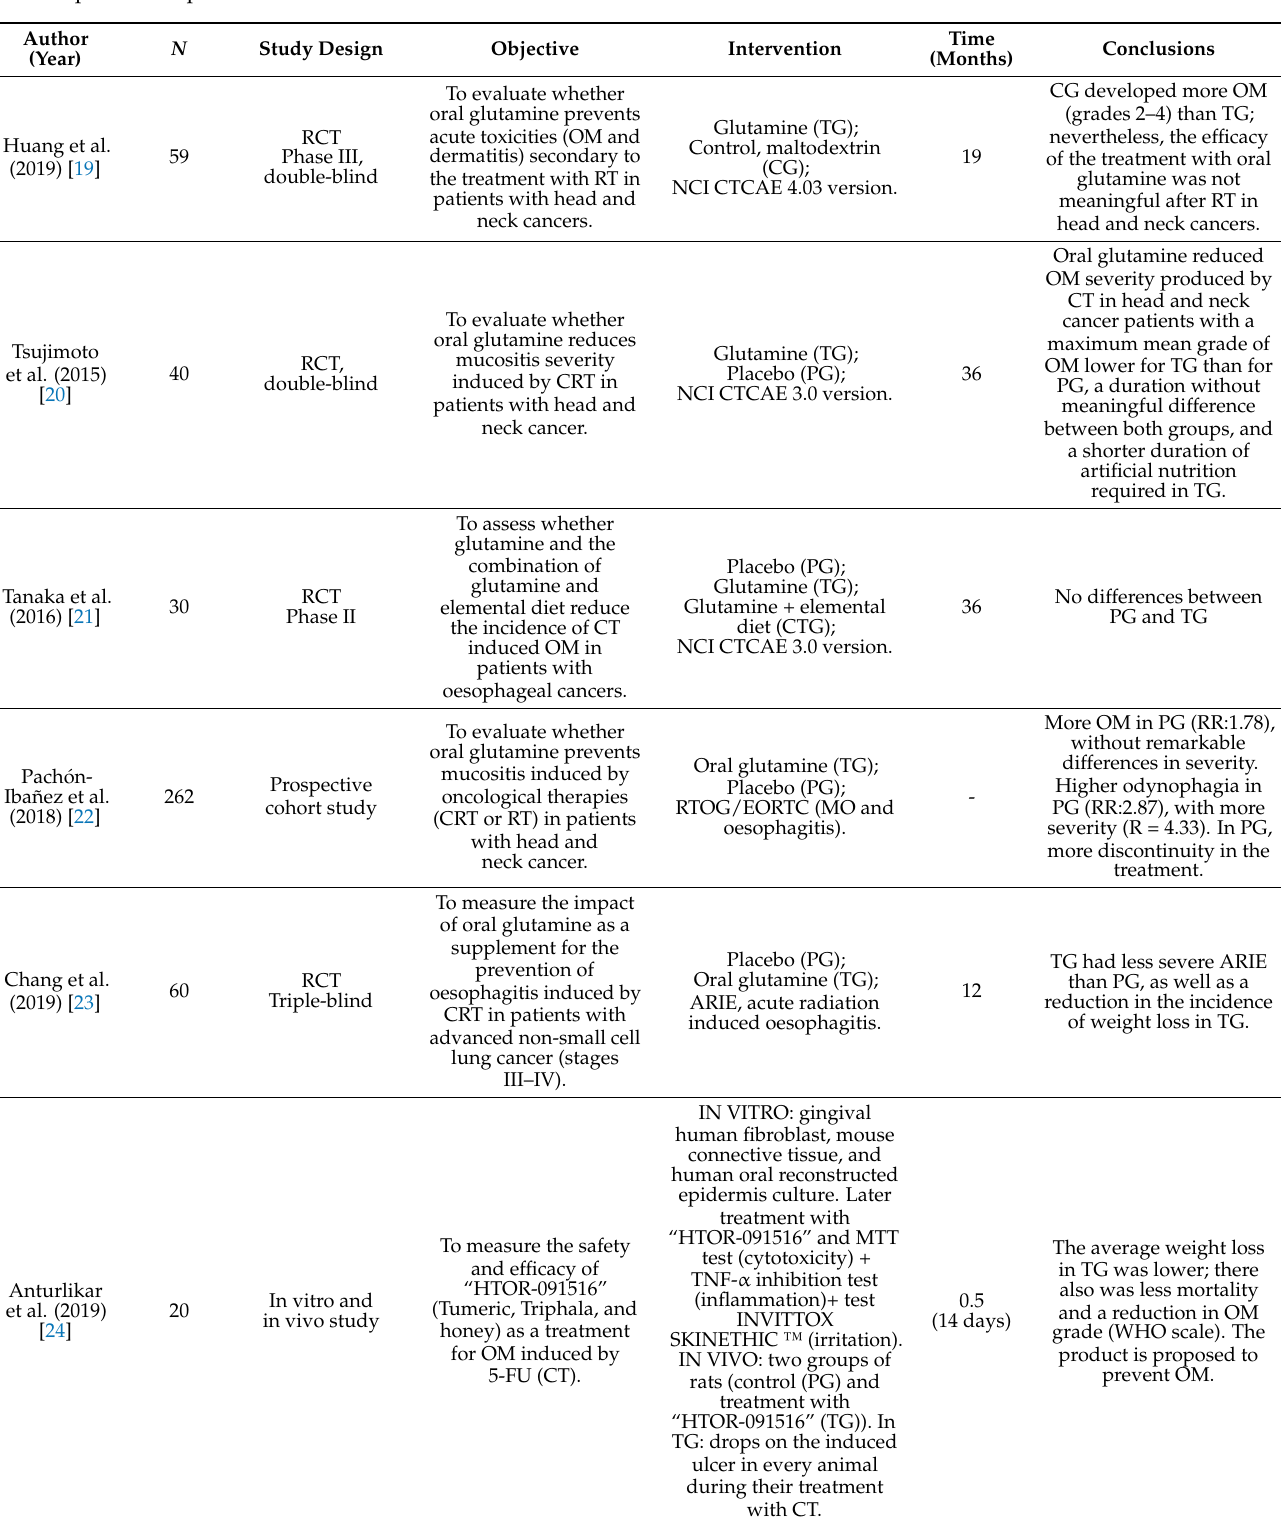
Table 1. Summary of studies investigating prevention or treatment of Oral Mucositis in cancer patients with dietary components or prevention